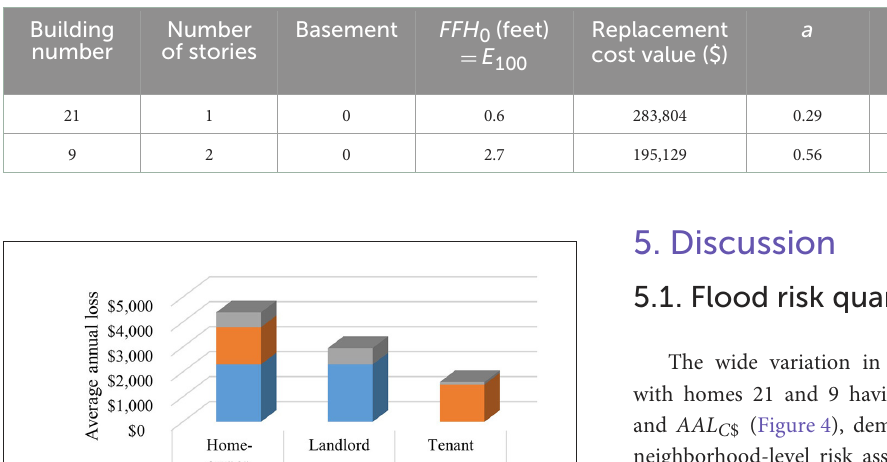
TABLE 2 Building attributes, initial first-floor height, replacement cost value, and regression parameters for residences with the largest and smallest total AALs for building + contents.